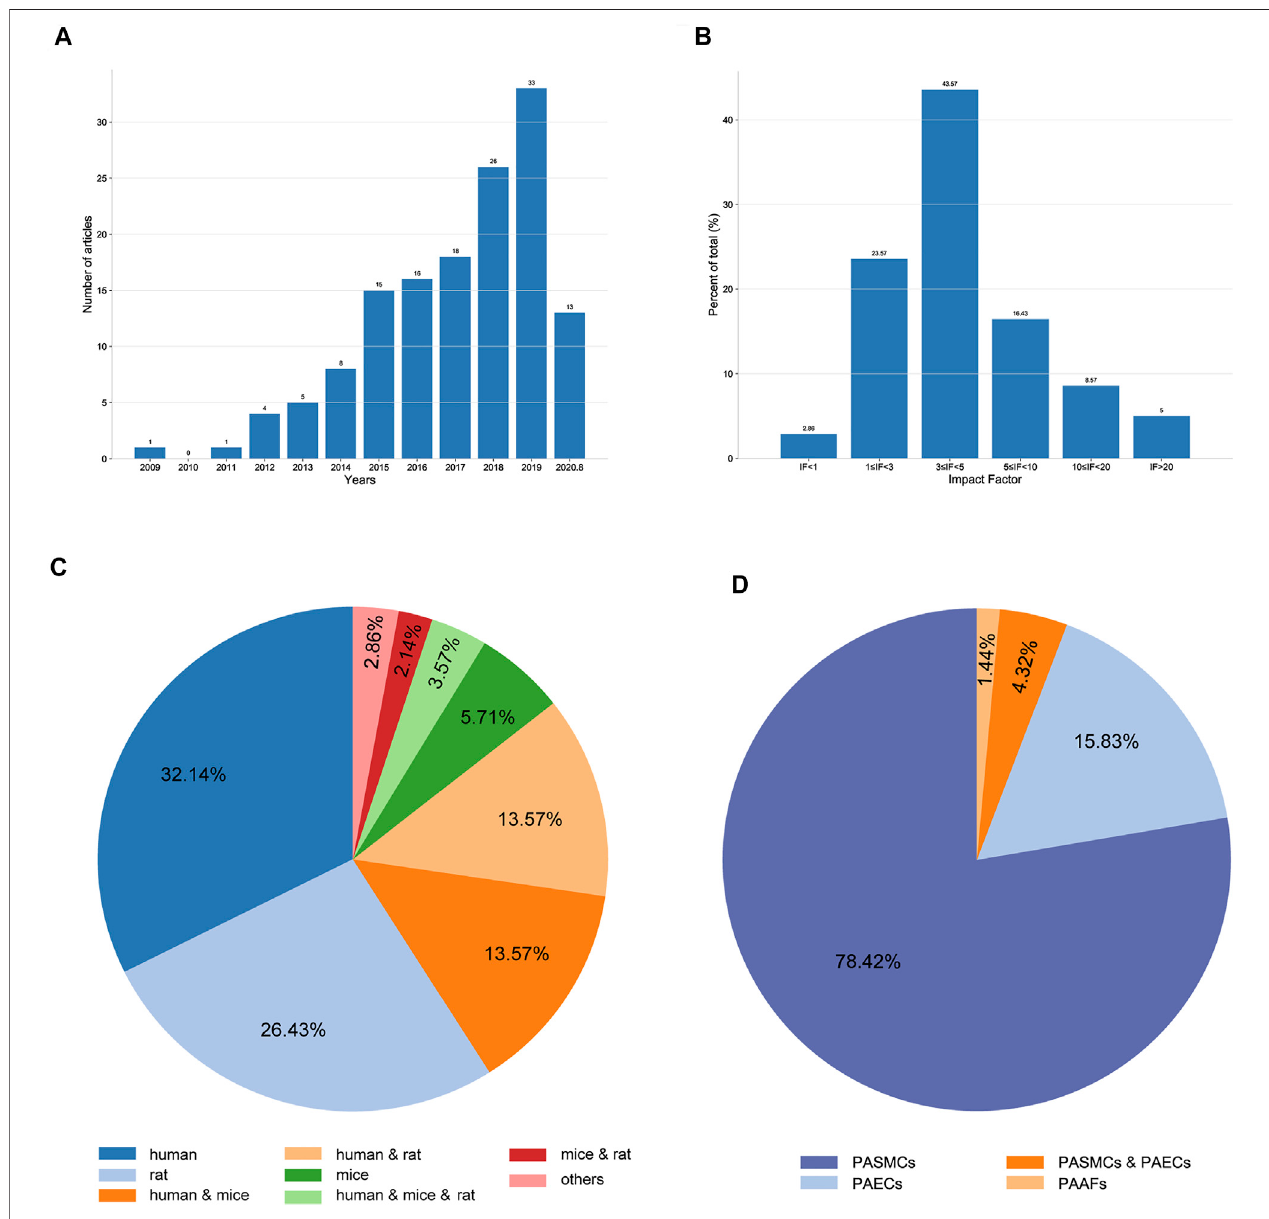
FIGURE2| Characteristicsoftheextractedstudies. (A) Distributionoftheincludedarticlesaccordingtothepublicationyear. (B) Distributionoftheincludedarticles according to the impact factor. (C) Proportions of different species studied in the included articles. (D) Proportions of different cell types used in the included articles.